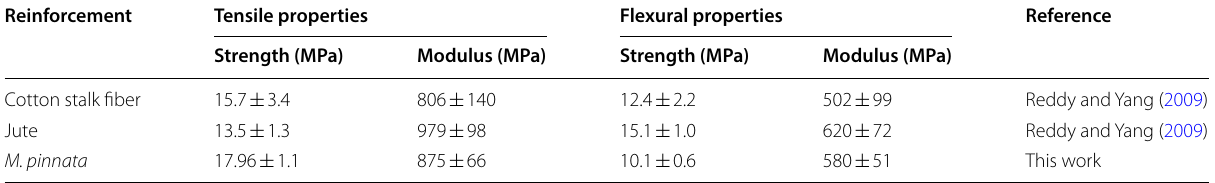
Table 3 Tensile and flexural properties of 50/50 ratio of M. pinnata /PP composites compression molded at 170 °C compared with cotton stalk fiber and jute PP composites